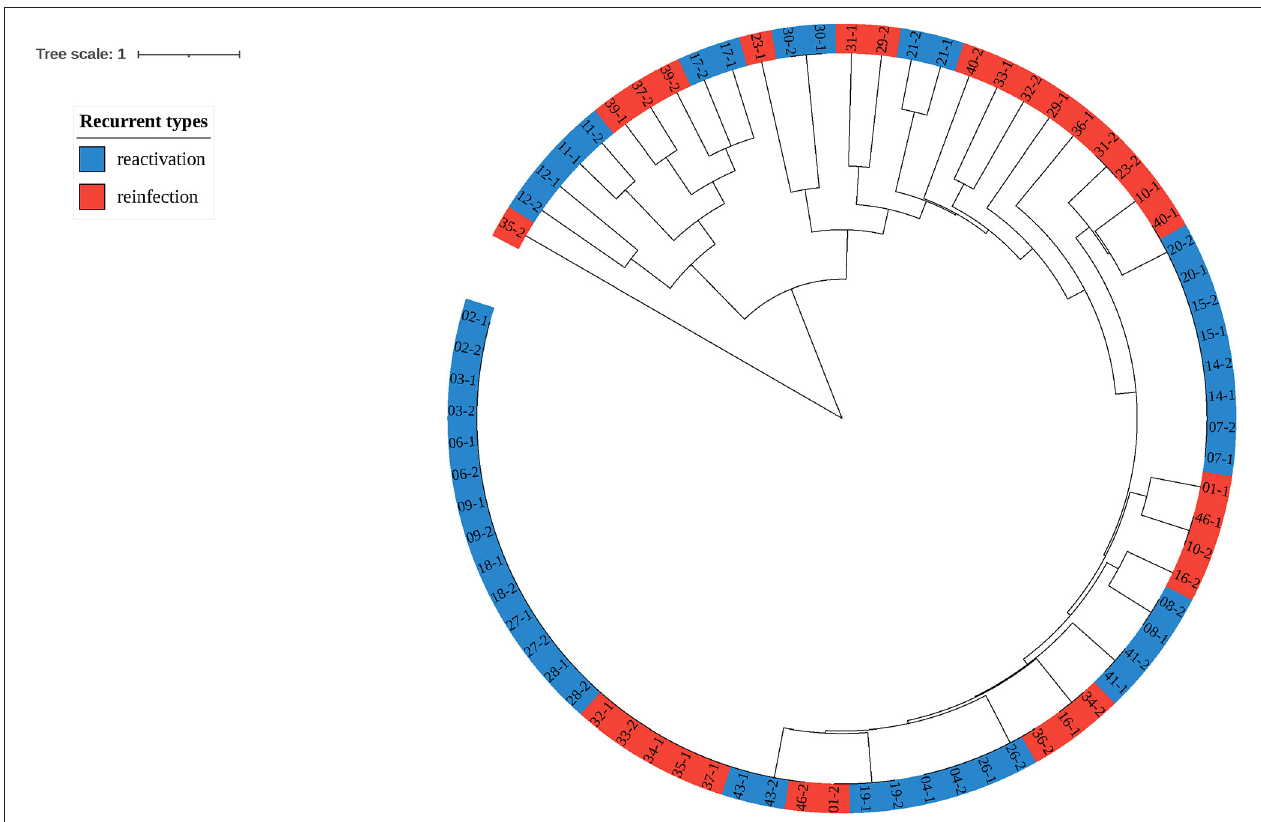
FIGURE 3 | Clustering tree of 37 pairs of recurrent tuberculosis isolates. The red label represents reinfection of tuberculosis, while the blue represents